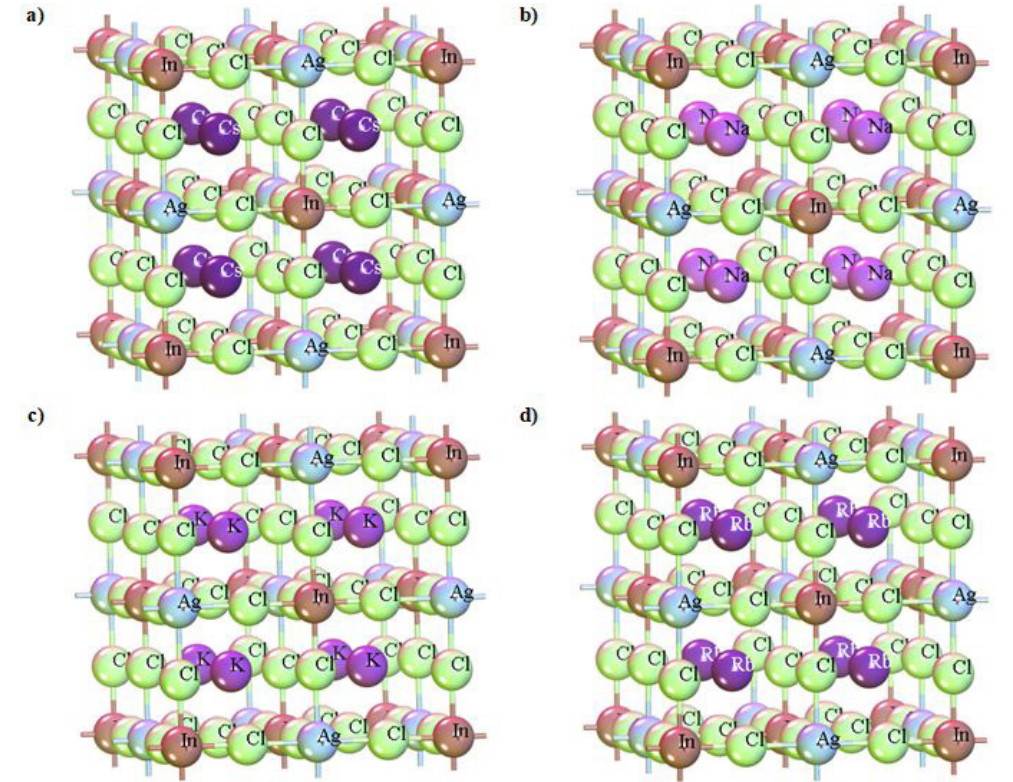
InAgCl , b) Optimized structure of Na 2 6